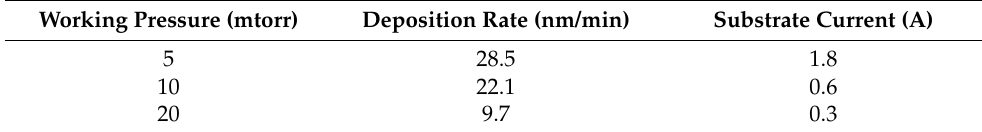
Table 1. Deposition rate and substrate current for different working pressures.